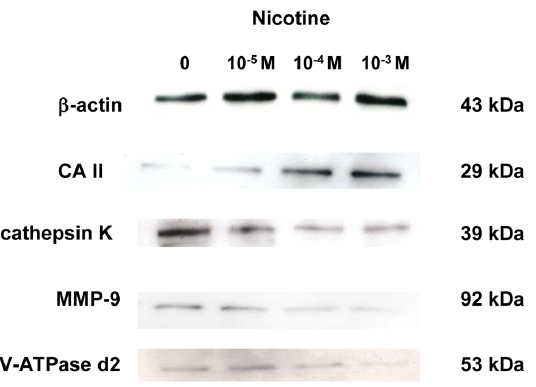
Figure 4. Effect of nicotine on protein expression of CA II, cathepsin K, MMP-9, and V-ATPase d2. RAW264.7 cells were cultured in differentiation medium with 0 (control), 10 2 5 , 10 2 4 , or 10 2 3 M nicotine for 5 days. The protein expression of CA II, cathepsin K, MMP-9, and V-ATPase was determined by Western